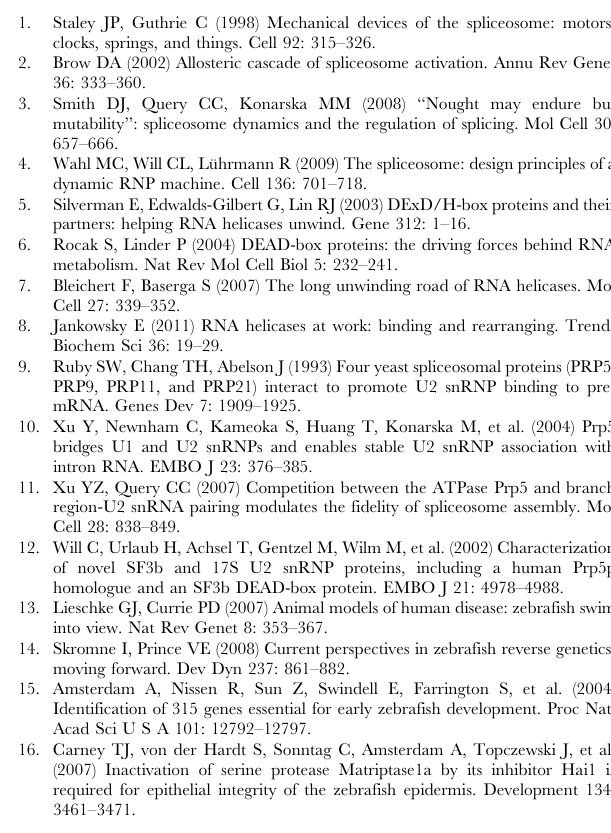
Figure S8 Expression of various molecular markers for digestive organs and brain is reduced in the Ddx46 hi2137/ hi2137 mutant. (A–F) The expression of her4 , neurog1 , and neurod for brain was examined using whole-mount in situ hybridization at 3 dpf. All lateral views, anterior to the left. (G–N) The expression of hlxb9la , cpa5 , gata6 , and dhrs9 for digestive organs was examined using whole-mount in situ hybridization at 3.5 dpf. All dorsal views, anterior to the top. In the Ddx46 hi2137/hi2137 mutants, the intensity and area of all of these gene expressions were markedly reduced at 3 or 3.5 dpf. Control larvae were sibling WT or Ddx46 hi2137/ + larvae and had normal phenotypes. Figure S9 Pre-mRNA splicing of the housekeeping gene actb1 , but not b2m , is unaffected in the Ddx46 hi2137/hi2137 mutant. (A–D) Scheme of the b2m and actb1 pre-mRNA regions analyzed for splicing (boxes, exons; lines, introns; arrows, primers) (A, C). The splicing status of b2m and actb1 pre-mRNA was monitored using RT-PCR with the primers indicated in scheme A and C, respectively. Total RNA was isolated from the heads of Ddx46 hi2137/hi2137 mutants (mut) and control (con) larvae. Un-